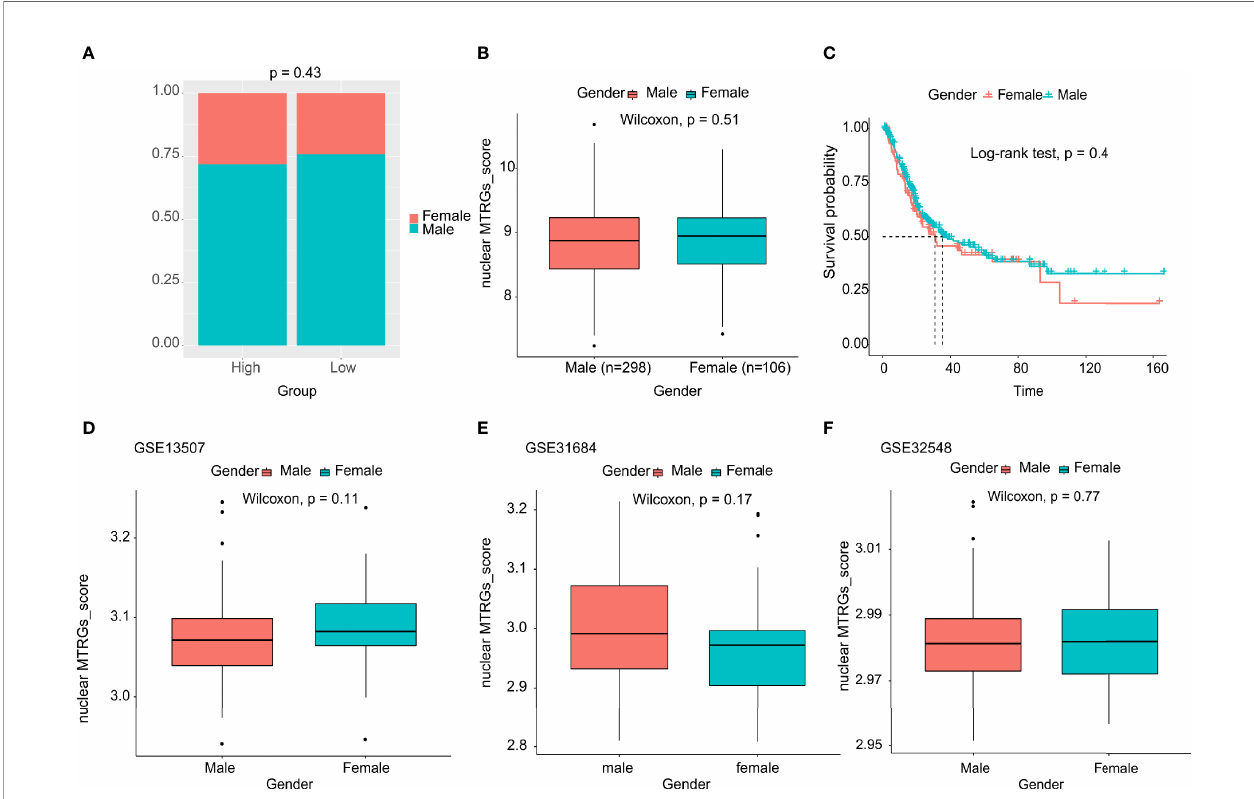
FIGURE 7 | Exploration of the clinical feature of gender between the high and low nuclear MTRGs score groups, and the investigation for the overall survival between the male and female BC